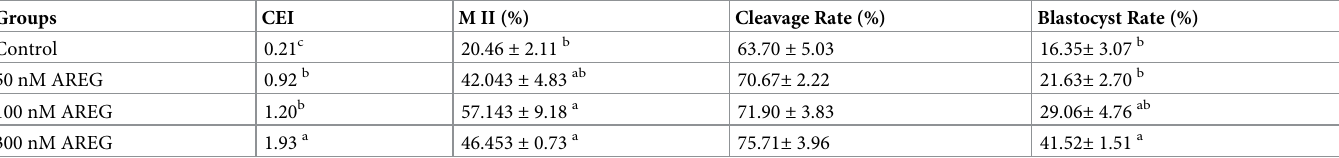
CEI: cumulus expansion index, M II (%): Percentage of oocytes at the M II stage. Cleavage and Blastocyst rates were assessed by in vitro fertilization in COCs. Different superscripts demonstrate significant differences (P < 0.05) within each column. 5 replicates and the minimum number of oocytes in each replicate were 50, 20 and 20 for assessment of development, MII rate and CEI, respectively.